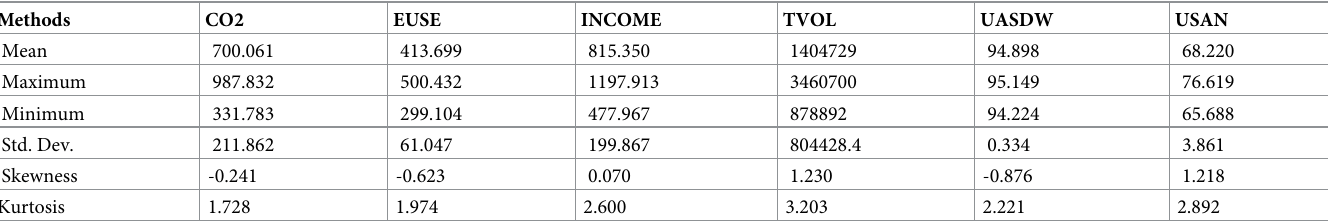
Table 2. Descriptive statistics.